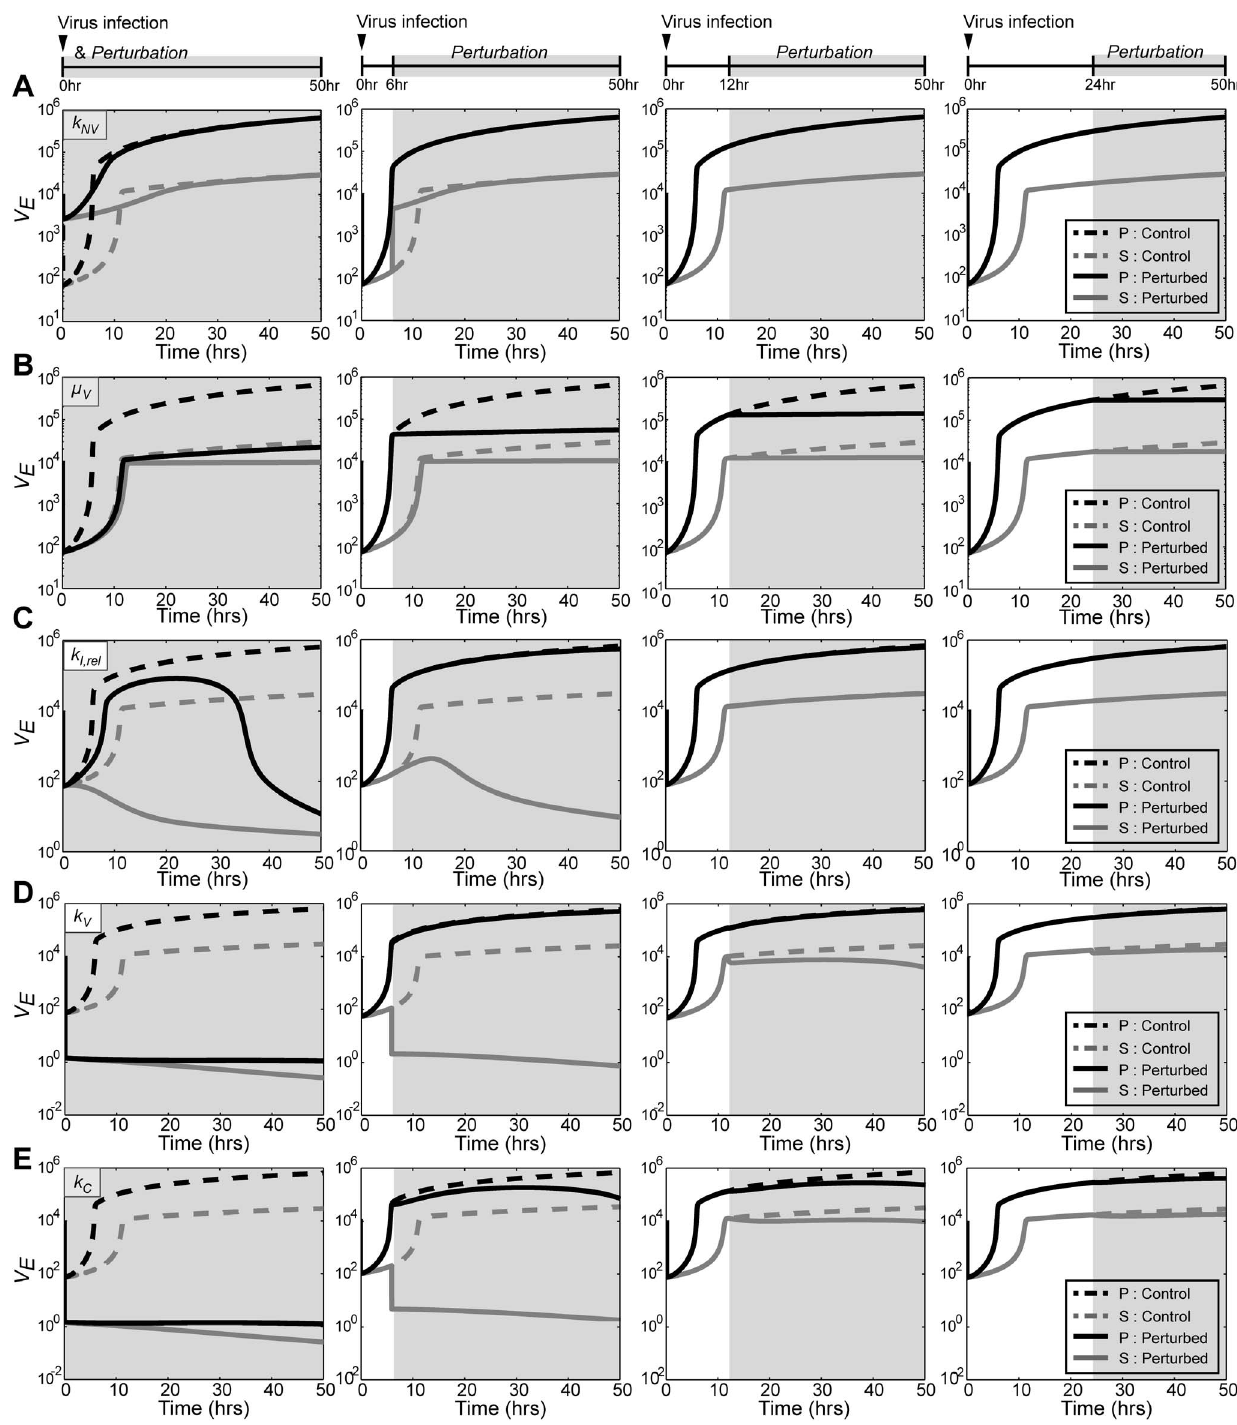
Figure 4. Effect of parameter perturbations on the production of influenza virus. Each parameter was numerically perturbed 0, 6, 12, or 24 hours after infection, and the dynamics of V E were simulated for a total 50 hours. The internalization rate k NV (A), the replication rate m V (B), and the release rate k C (E) were reduced 50-fold, whereas the transition rate k I,rel (C) and the attachment rate k V (D) were increased 50-fold. The dynamics of the seasonal strain ( gray solid line ) and the pandemic strain ( black solid line ) without any perturbations were compared with those of the perturbed simulations of the seasonal ( gray dotted line ) and pandemic ( black dotted line ) strains. doi:10.1371/journal.pone.0068235.g004 production of the pandemic strain was similarly affected by 148.7, respectively, whereas the D 50 of k C was 90.4. This result perturbations of k V and k I,rel , with D 50 values of 144.3 and indicates that the release process of the newly synthesized